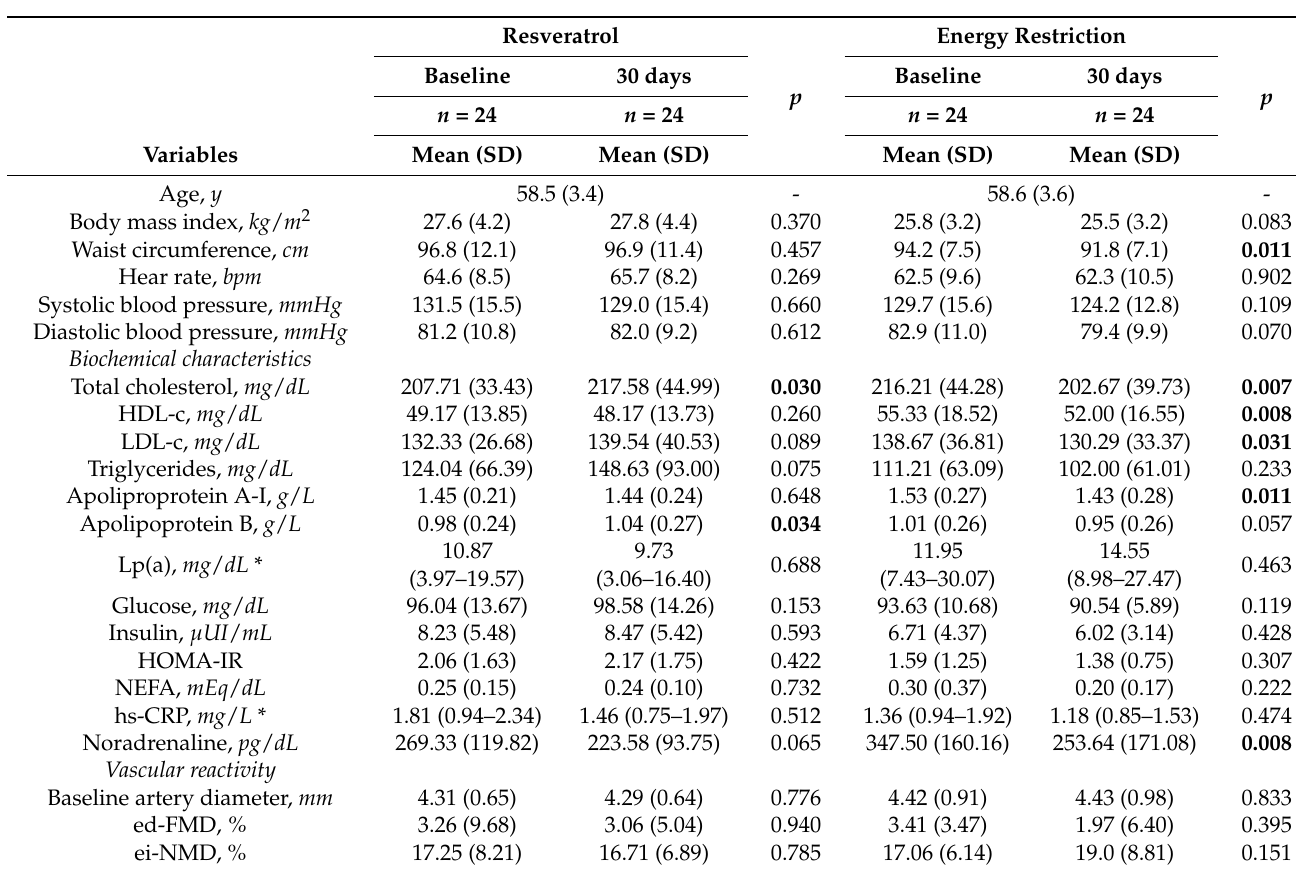
Table 1. Baseline and post-intervention characteristics of the